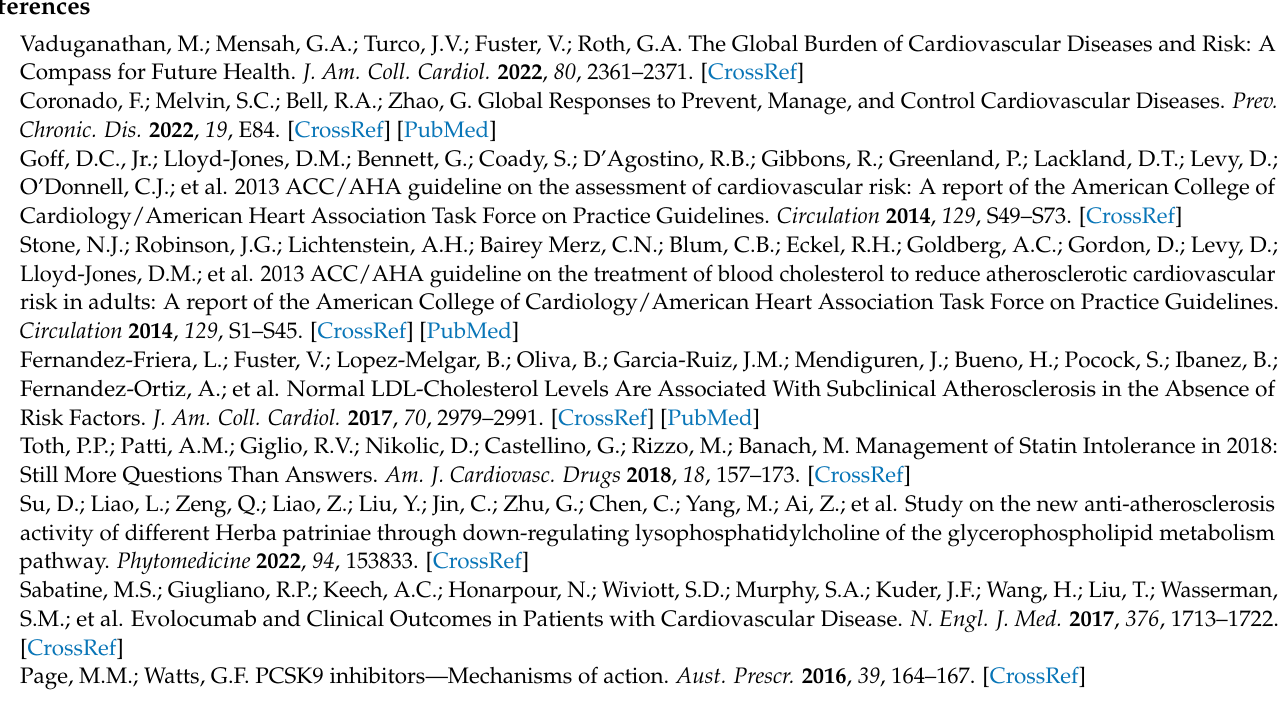
knockout; HFD: high-fat diet; NCD: normal-chow diet; CE: cholesteryl